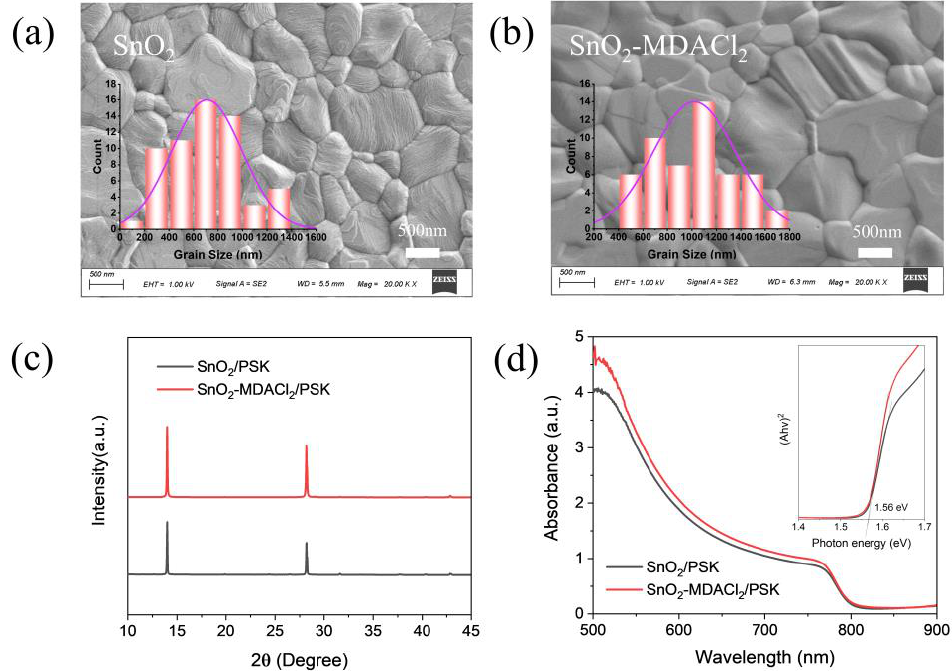
Figure 3. ( a , b ) SEM images of perovskite films grown on SnO 2 and SnO 2 -MDACl 2 ETLs. Insets show the statistical diagrams of the grain size distributions based on the SEM images. ( c ) XRD patterns of perovskite films grown on FTO/SnO 2 and FTO/SnO 2 -MDACl 2 substrates. ( d ) UV-visible absorption spectra and Tauc plots of the perovskite films grown on SnO 2 and SnO 2 -MDACl 2 ETLs. Steady-state photoluminescence (SSPL) and time-resolved photoluminescence (TRPL) measurements were utilized to further study the charge dynamics at the ETL/perovskite